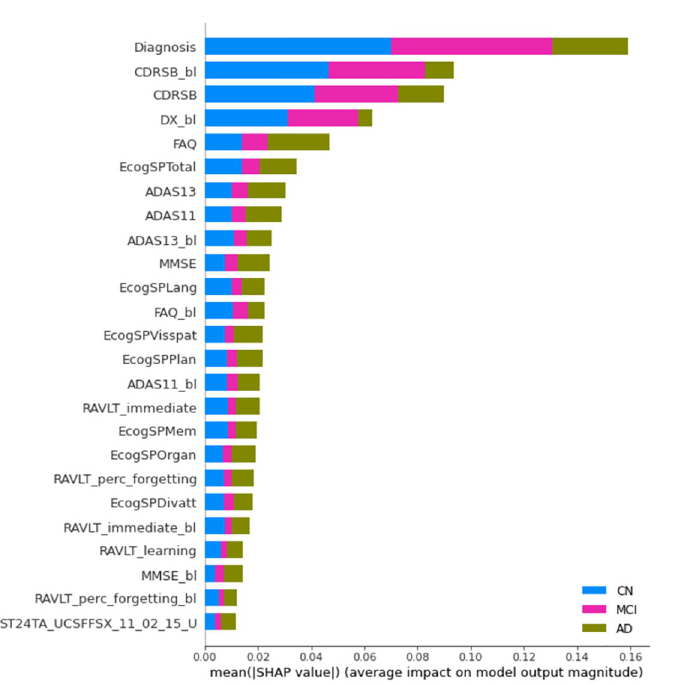
Fig 5. Mean absolute SHAP values computed from the RF system. Same legend than Fig